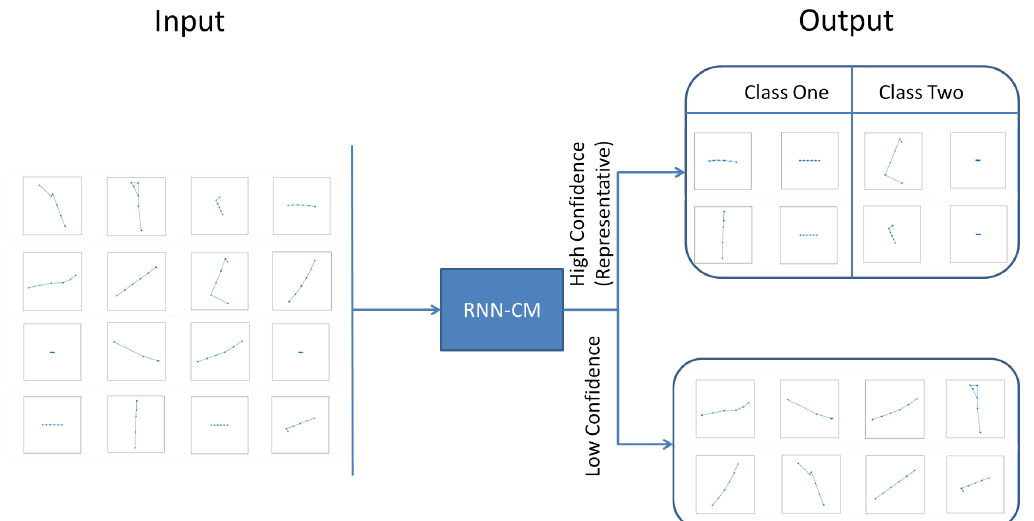
Figure 1. The recurrent neural network with confidence measure (RNN-CM) process with sample inputs. Left side contains the input segments from marine animals with multiple age or gender groups, which are processed by RNN-CM. The processed segments can be divided into high and low confidence ones. The patterns of low confidence segments are shared by different animal groups, and thus, RNN-CM has low confidence in identifying which group they are extracted from. High confidence segments can be further divided according to animal age or gender groups, with relatively high